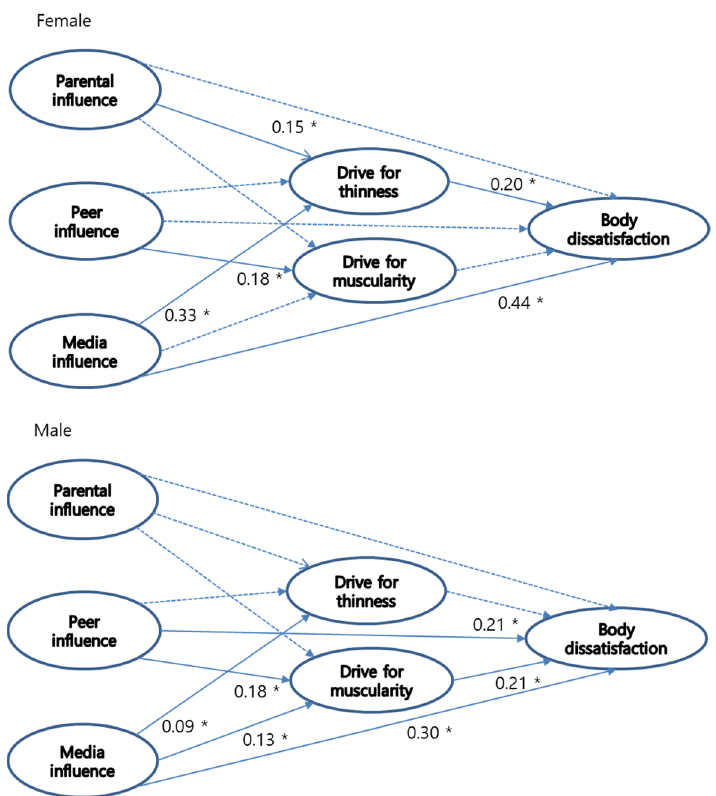
Figure 1. Final model estimation with standardized coefficients. Note. * p < 0.05; significant path coefficients are shown in bold line; dotted line = non-significant.